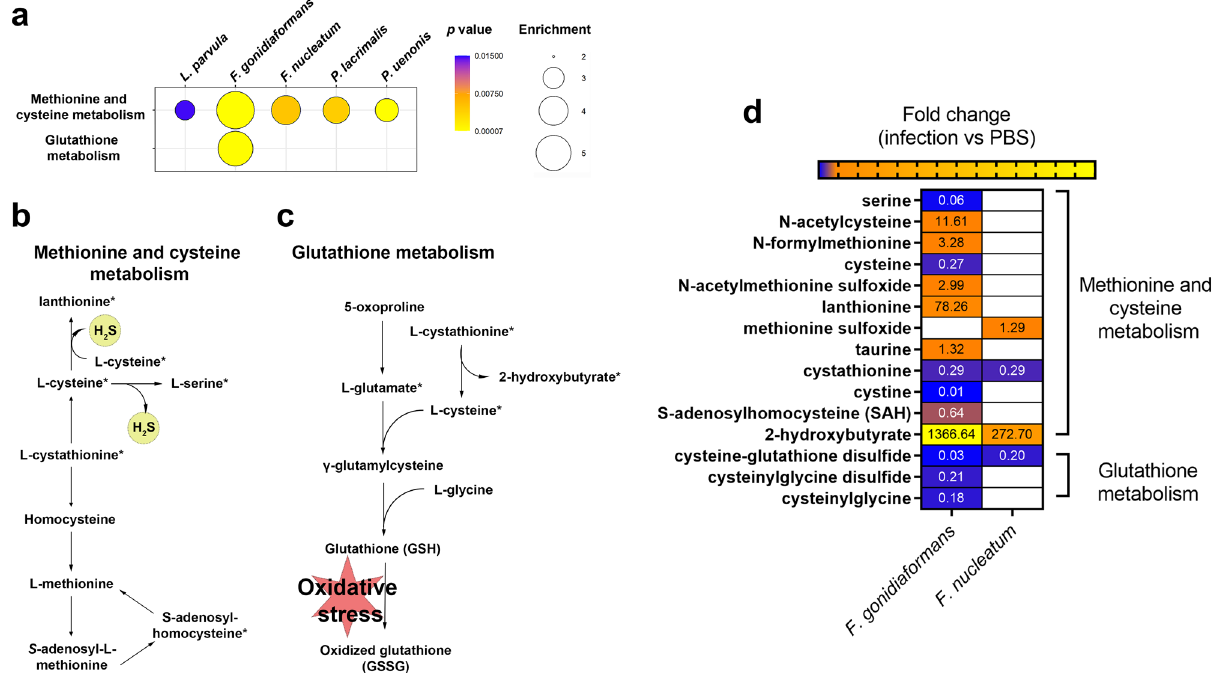
Fig. 7 Fusobacterium spp. modulate metabolites associated with hydrogen sul fi de production and oxidative stress. a Bubble plots representing enrichment of methionine and cysteine metabolism and glutathione metabolism from metabolomics data derived from 3-D cervical cells infected with BVAB. Bubble sizes are proportional to the enrichment factor and bubble colors indicate signi fi cance. b Methionine and cysteine metabolic pathway depicting hydrogen sul fi de production (yellow circles). c Glutathione metabolic pathway that participates in the oxidative stress response. Asterisks next to metabolites are also represented in the heatmap. d Heatmap representing statistically different ( p < 0.05) metabolites corresponding to methionine and cysteine metabolism and glutathione metabolism that were differentially accumulated (orange and yellow shading) or depleted (blue shading) during infection with Fusobacterium species. Fold change difference between infection with and mock-infected controls are indicated as numerical values within the heat map cells. A minimum of n = 3 independent replicates were performed and measured for each